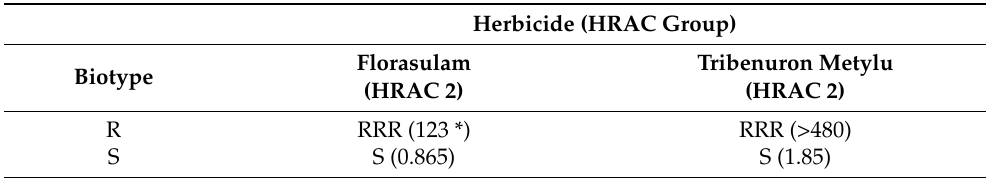
Table 1. Characteristics of herbicide-resistant (R) and -susceptible (S) cornflower biotypes ( Centaurea cyanus L.) used in the pot experiments.